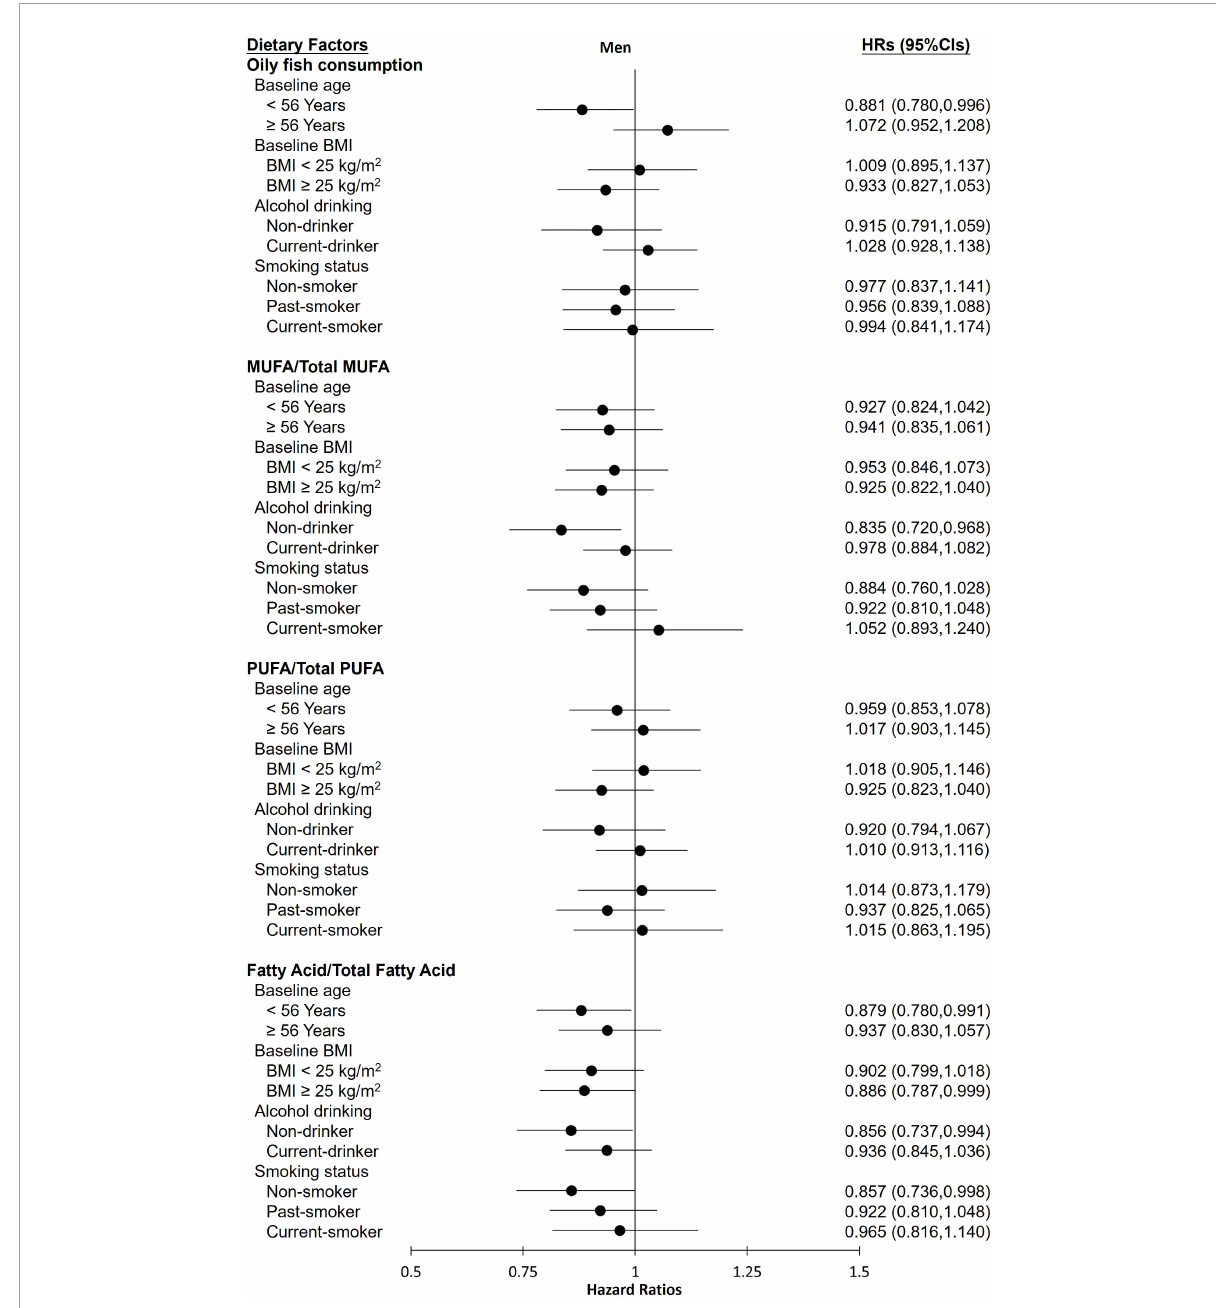
FIGURE1 Hazard ratios (HRs) of fatty liver index (FLI)-non-alcoholic fatty liver disease for the highest categories compared with the lowest categories of oily fish and its fatty acid intake among male participants in the current cohort study. Analyses were stratified by body mass index (BMI), age, smoking status, and drinking status. HRs, hazard ratios; MUFAs, monounsaturated fatty acids; PUFAs, polyunsaturated fatty